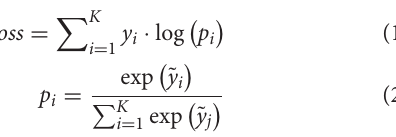
Frontiers in Psychology |